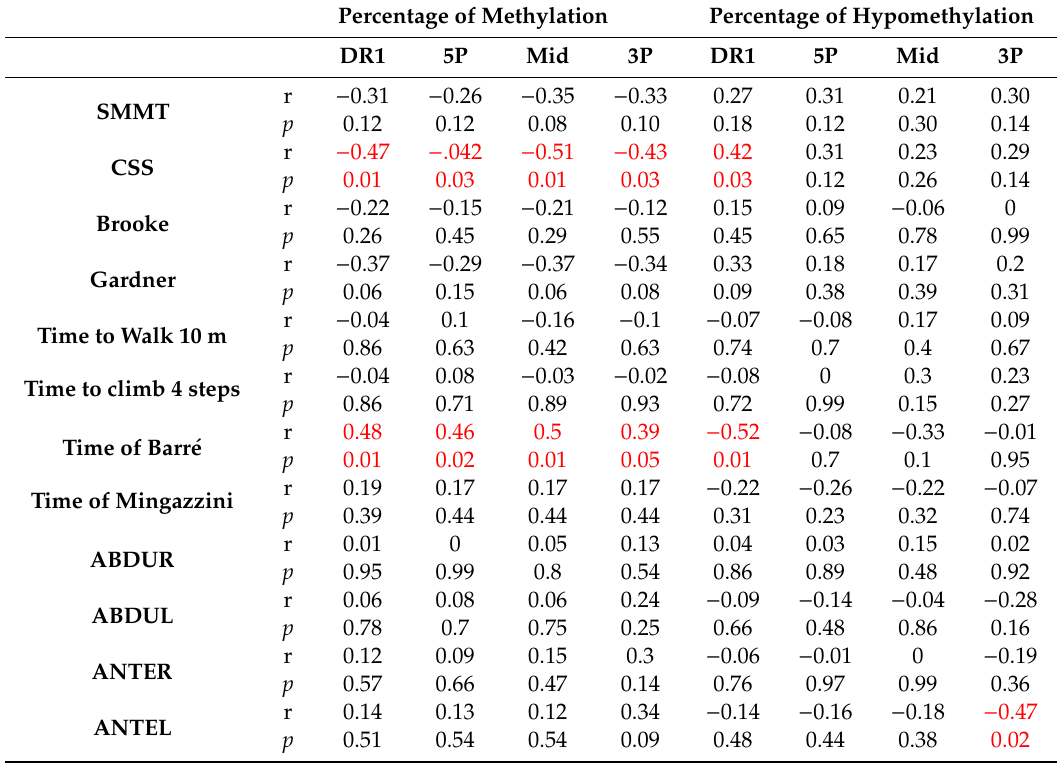
Table 2. The correlation between functional scales and